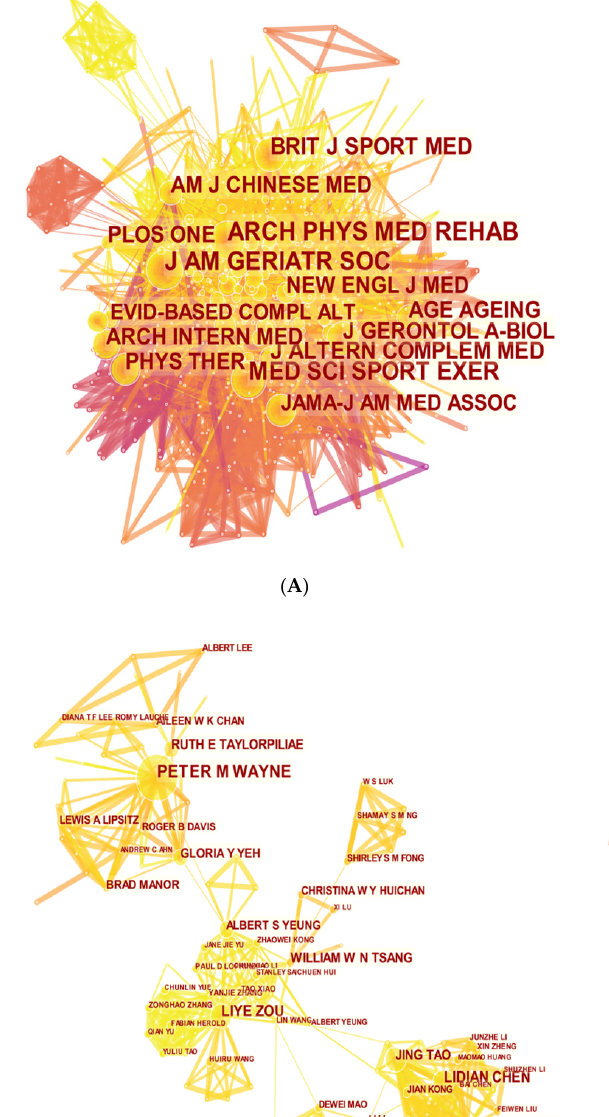
Table 3. Ranking of top 10 authors, co-cited authors, and co-cited references in the field of Tai Chi research from 1980 to